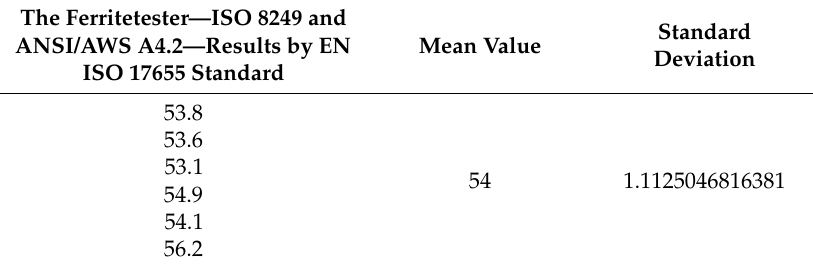
Table 3. Magnetic phase testing results according to EN ISO 17655 and EN ISO 8249.